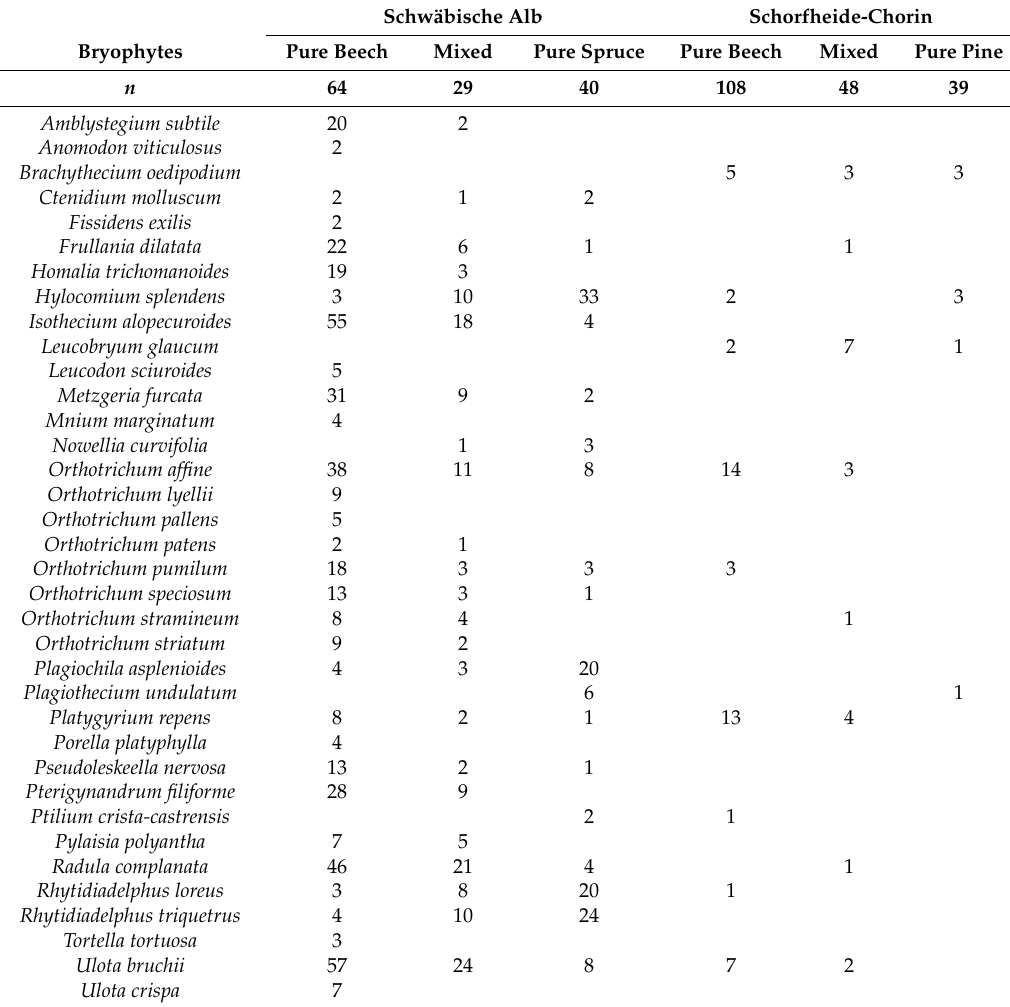
Table A3. Number of occurrences of threatened and protected bryophyte species in the survey plots ( n = total number of plots) of pure and mixed stands in Schwäbische Alb and Schorfheide-Chorin. Species with single occurrences are listed at the end of the table. All species are listed in the red list of bryophytes of